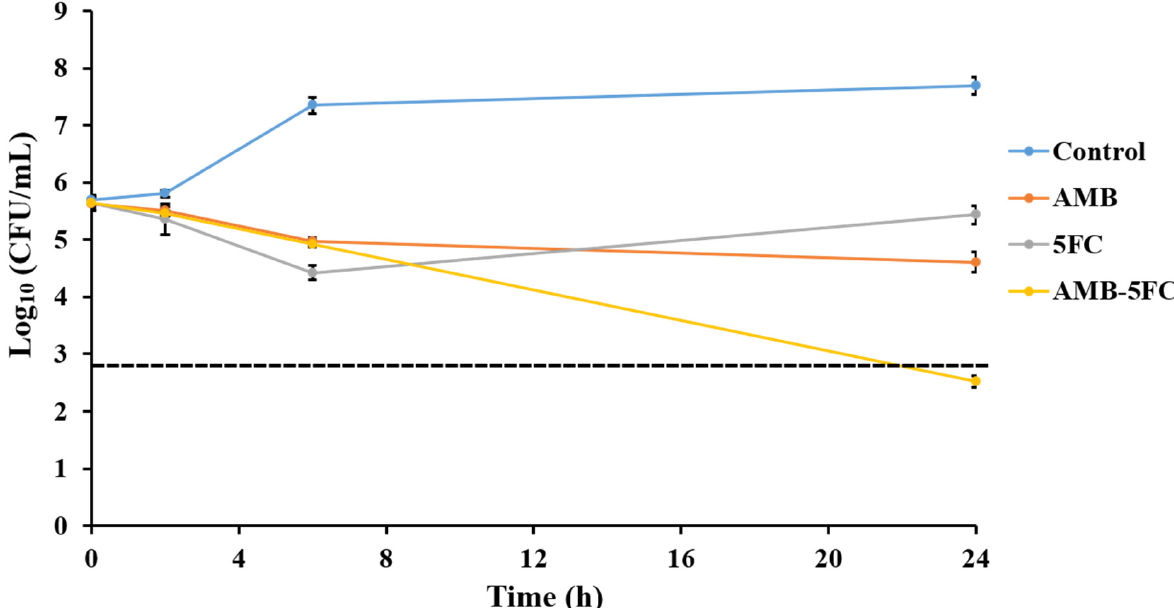
Figure 6. In vitro activities of AMB (1 µg/mL) and 5FC (0.1 µg/mL) alone and in combination against C. glabrata IFM60089 as determined by the time-killing assay. The detection limit was 20 CFU/mL. Dashed lines represent a >99.9% growth reduction compared with the initial inoculum size for determination of fungicidal activity. The AMB combination with 5FC showed synergistic and fungicidal actions. Each data point represents the means ± standard deviation of results from two independent experiments.